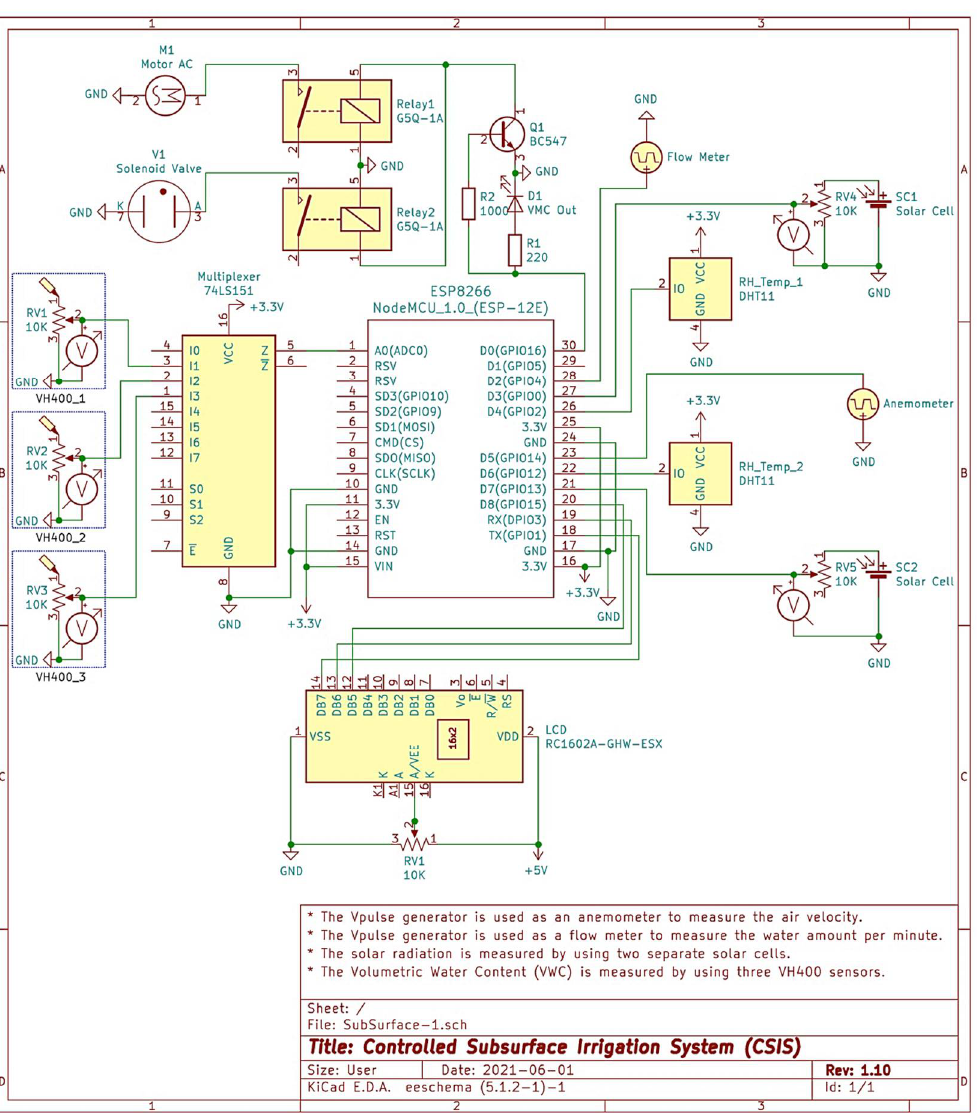
Figure 5. The detailed schematic KiCad diagram with successful electrical rules check.